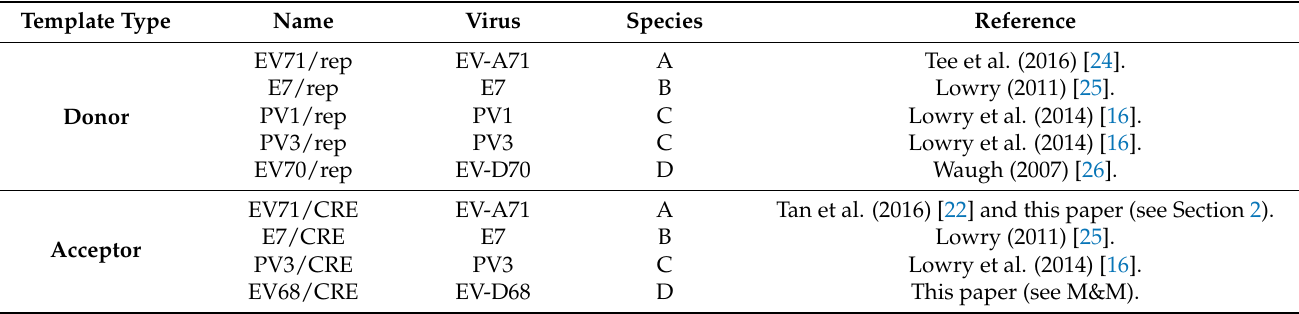
Figure 1. Schematic representation of donor replicon RNA templates. The genetic structure is shown for EV71/rep, E7/rep, PV1/rep, PV3/rep, and EV70/rep. Numbers below refer to the nucleotide number within VP1 at which the virus sequence restarts, relative to its position in the full-length genome. For EV70/rep, we also denoted the last nucleotide of the VP4 fragment present upstream of the luciferase gene. Table 1. Acceptor and donor